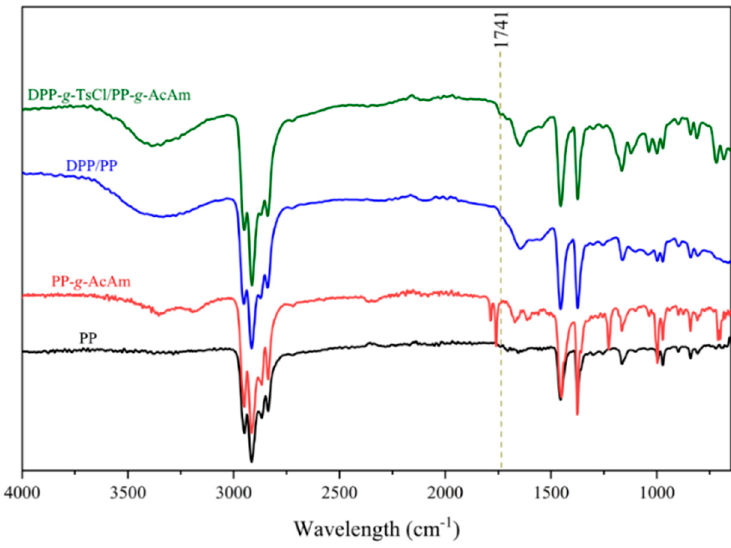
Figure 6. FTIR spectra of PP, PP- g -AcAm, DPP/PP, and (DPP-T)- g -TsCl/PP- g- AcAm.